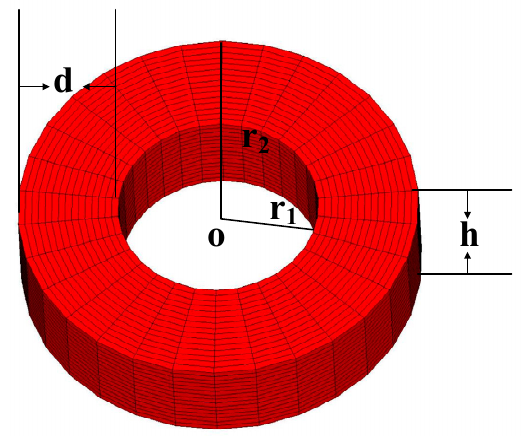
Figure 9. Detection coil 3D simulation model. The average radius, r , and height, h , of the ACSM probe detection coil were set as 2.25 mm and 1.5 mm. The average radius, r , and height, h , of the probe detection coil were unchanged. The inner and outer diameter difference, ∆ r , was set to 0.5 mm, 1.5 mm, and 2.5 mm. When the ∆ µ n was 125%, the difference of the probe output voltage with different inner and outer diameter difference parameters changes with lift-off, as shown in Figure 10.